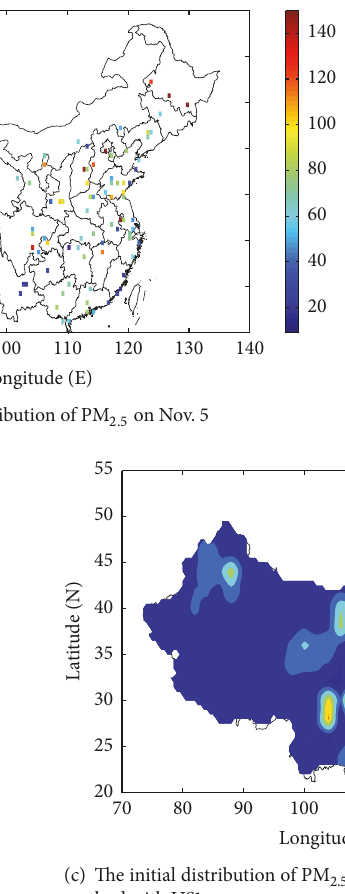
Figure 6: The 2D images of the initial distribution inverted by the adjoint assimilation method with different schemes.